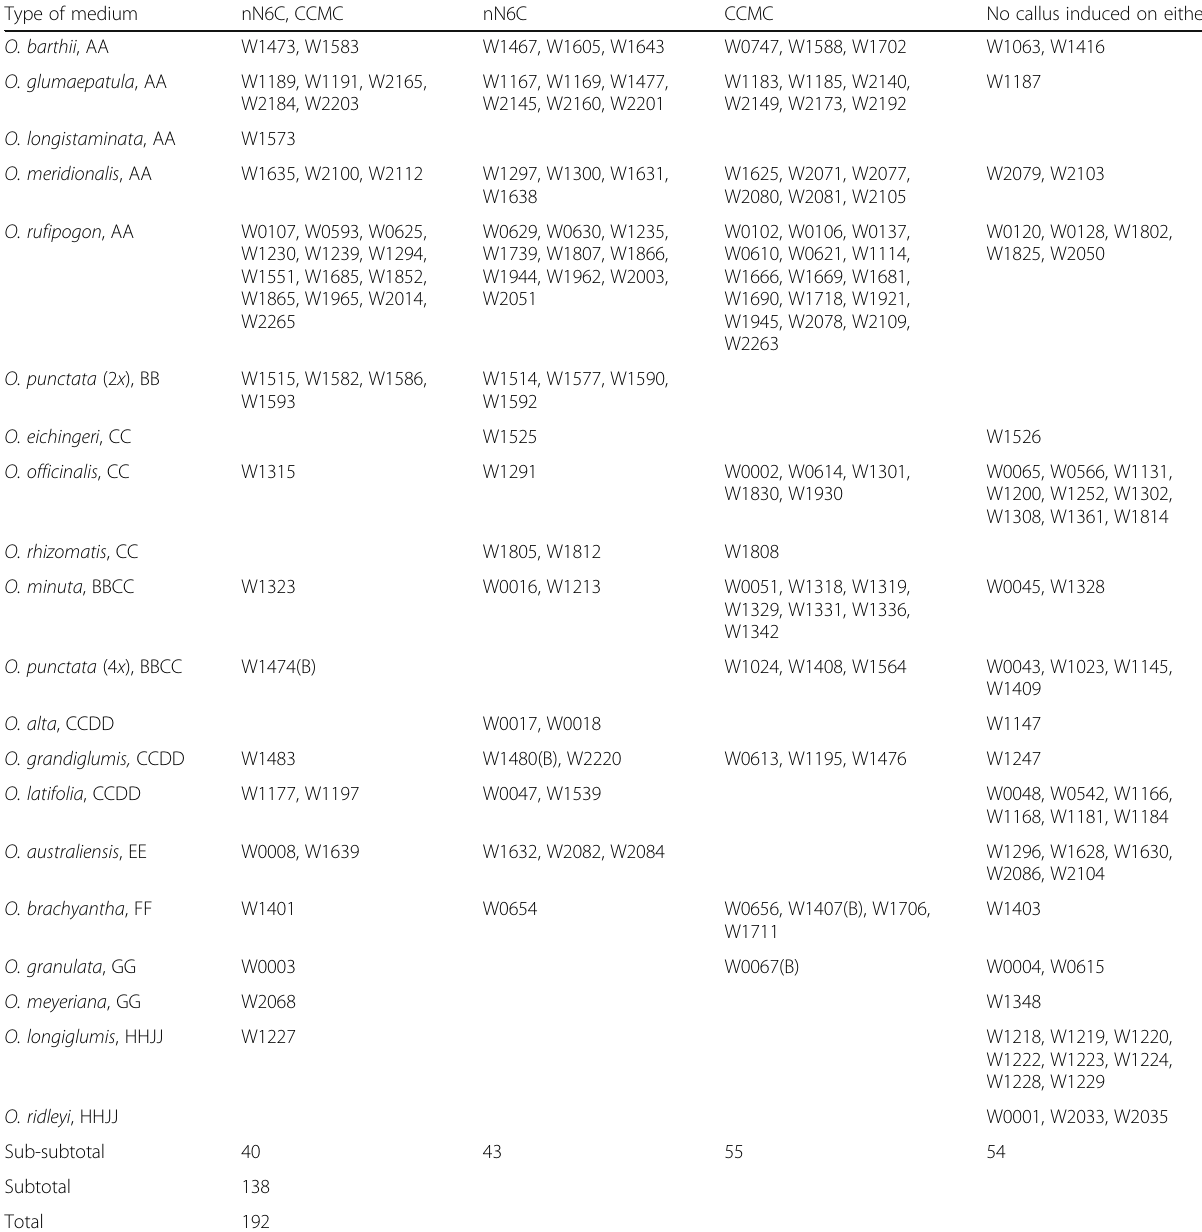
Table 1 Callus induction from immature embryos of wild Oryza accessions on different callus-inducing media Type of